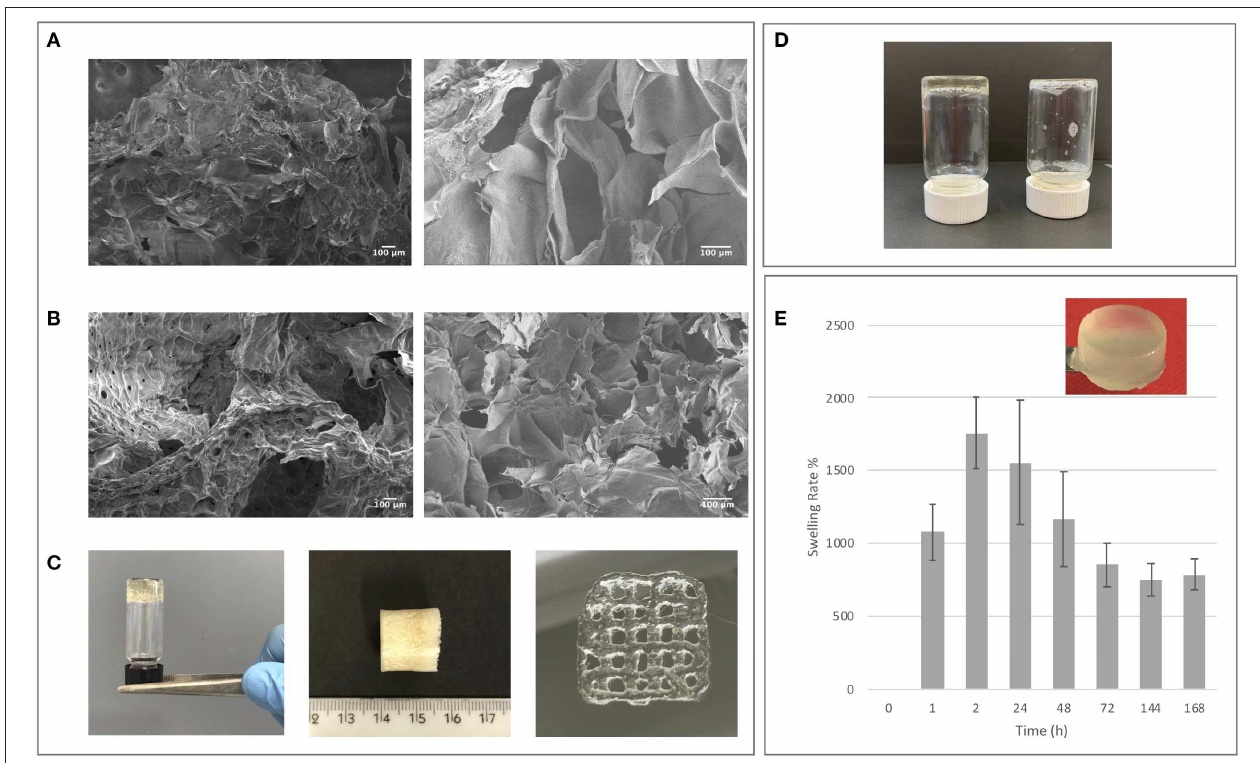
FIGURE 4 | (A) SEM control images of non-crosslinked GE-CH samples. (B) SEM images of crosslinked GE-CH samples. (C) GE-CH hydrogel, dried samples, and printed formulations. (D) Test tube inversion method confirming hybrid hydrogel formation of GE-CH compared with unfunctionalized GE-CH in liquid form. (E) Swelling analysis of GE-CH hydrogel reported at time points from 0 to 168h.